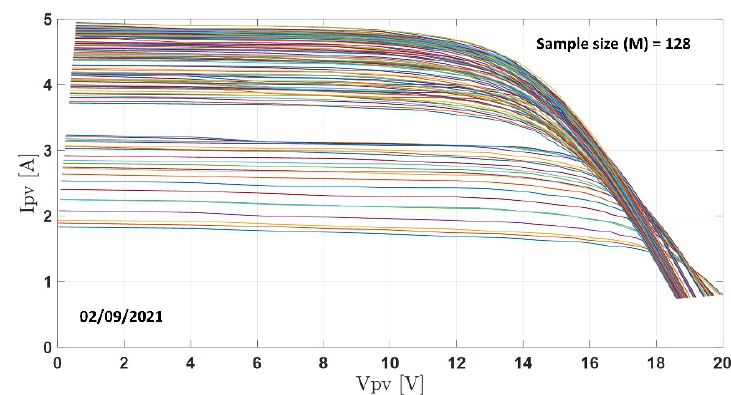
Figure 8. 128 I–V curves after withdrawing the abnormal ones .